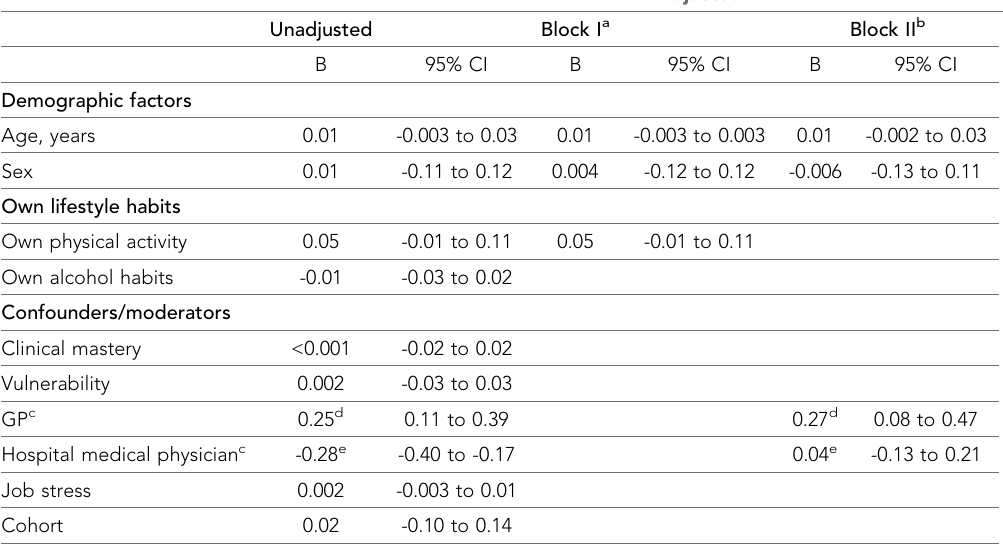
Table 2. Factors associated with counselling about alcohol habits in